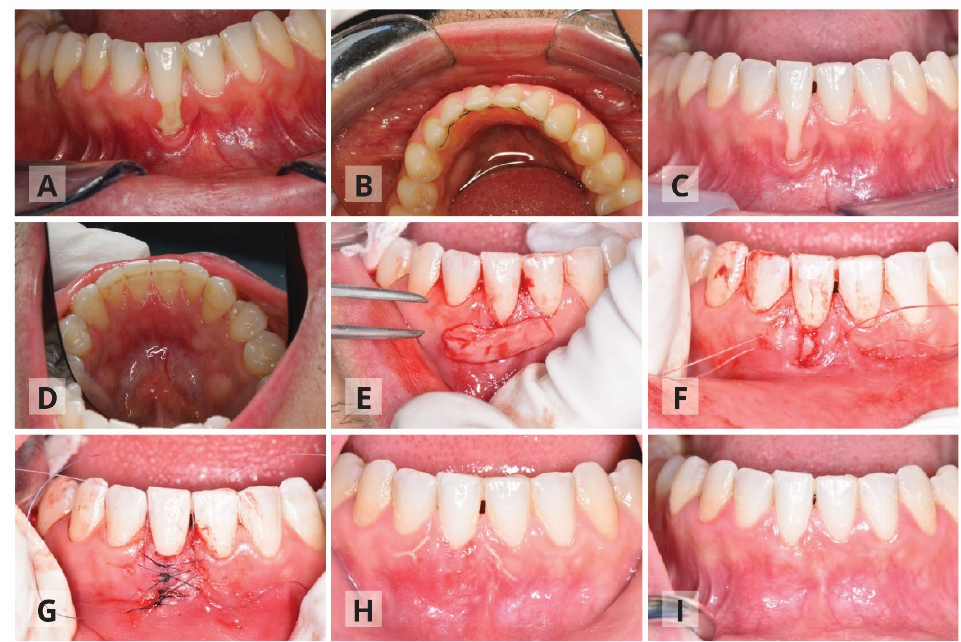
Figure 1 . First protocol, which included bonded lingual retainer removal. Patient number thirteen— thirty-one-year-old male arrived with Miller class III recession in tooth #41. Ten years post- orthodontic treatment, with bonded lingual retainer present ( A , B ). Three months after removal of the bonded lingual retainer and prior to surgery ( C , D ). During the surgery, the tunneling procedure that includes insertion of connective tissue graft ( E , F ). Double papilla suturing and addition of coronal anchoring sutures ( G ). Gingival healing two weeks post-surgery ( H ) and three months post-surgery ( I ).